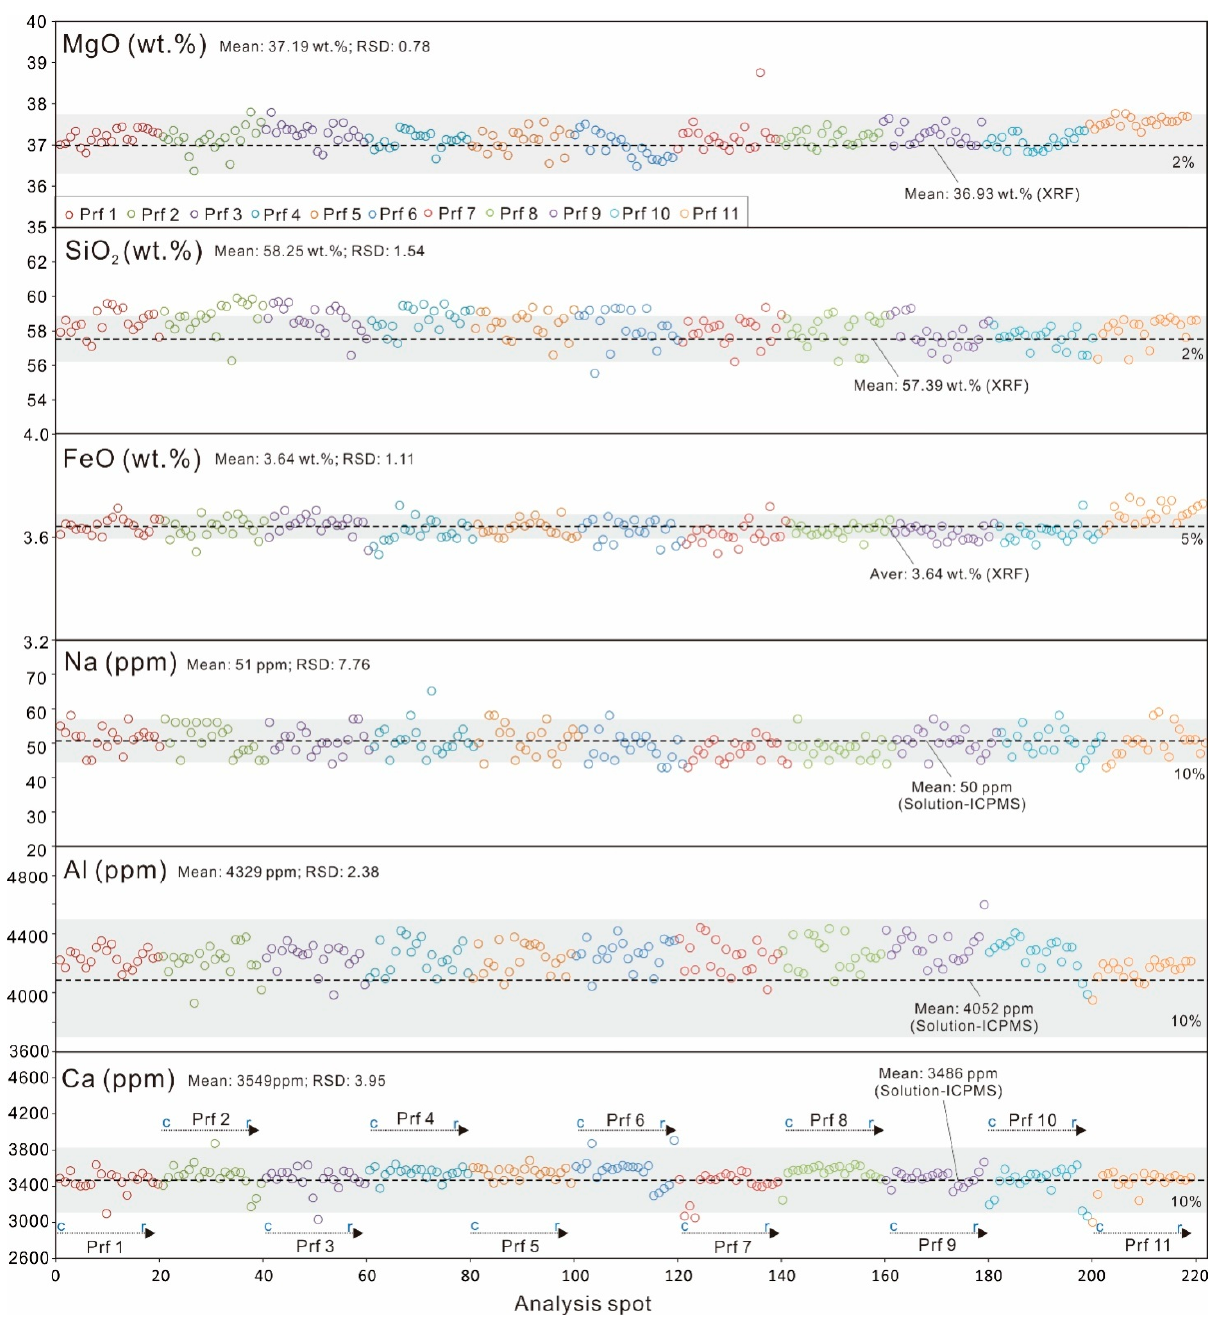
Figure 2. Core-to-rim chemical profiles using EPMA for MgO, SiO 2 , FeO, Na, Al, and Ca for MK-1 orthopyroxene. The relative standard deviations (RSD) display the dispersion of the data. The dotted line represents the mean value obtained by XRF or solution-ICPMS. Light shaded area represents 2% to 20% of variation from the mean. Prf1 profile 1.